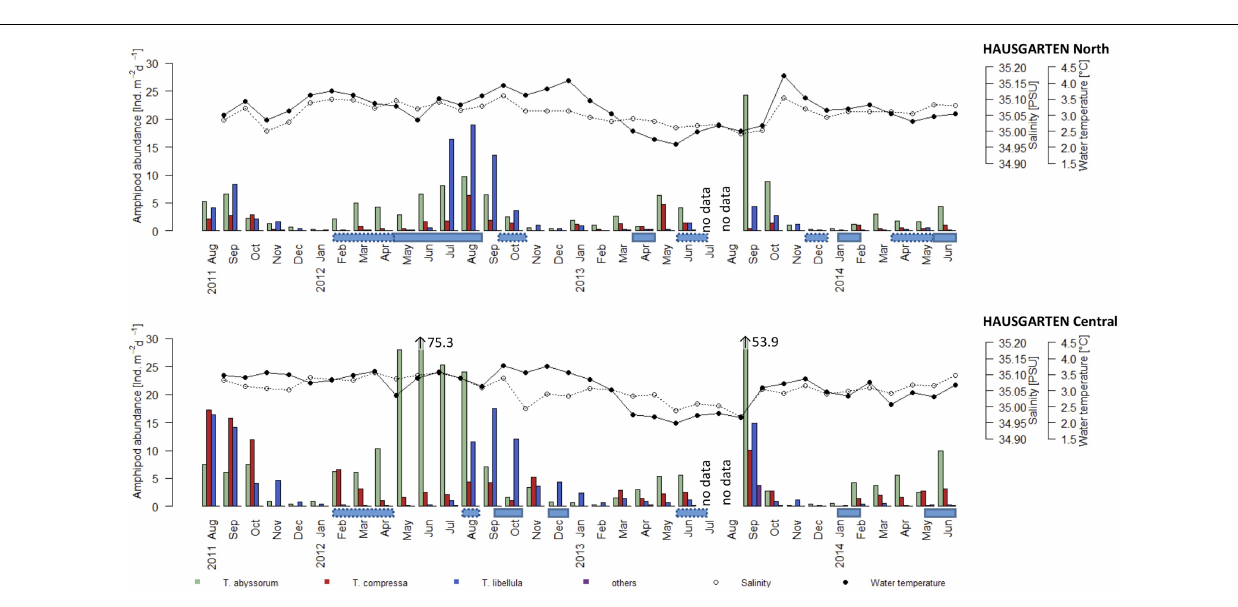
Frontiers in Marine Science |